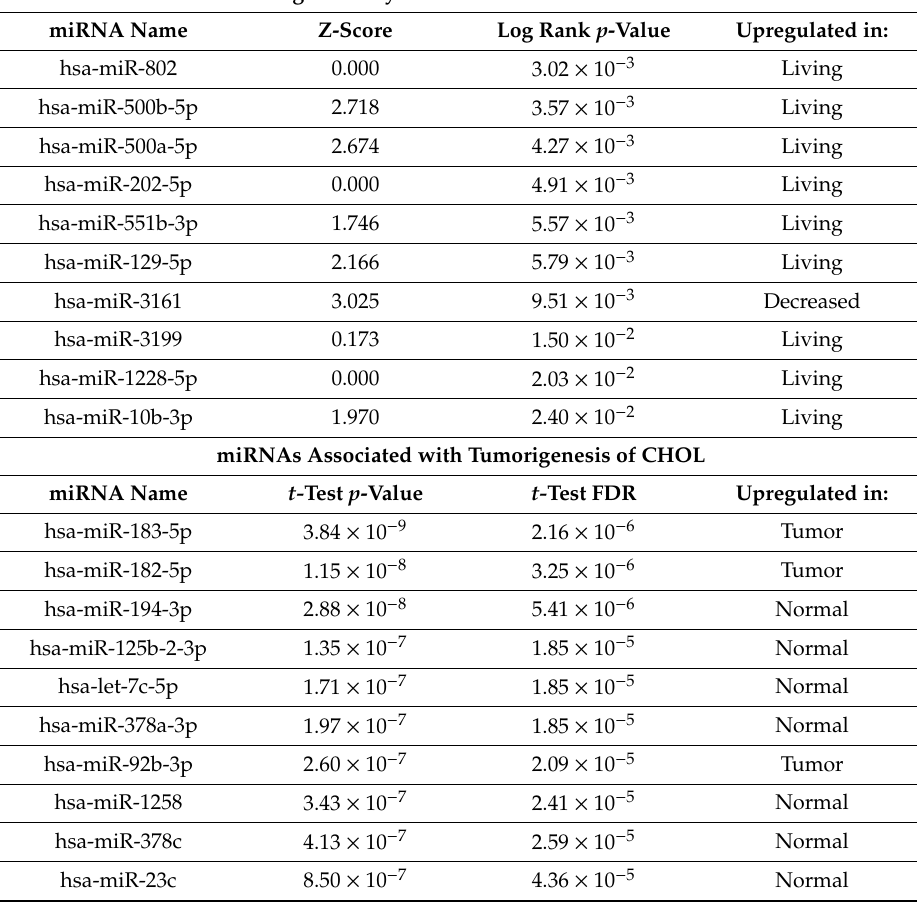
Figure 3. Most significant di ff erences of miRNAs in CCA. List selected from OncoMir Cancer Database (OMCD) website. After statistical analysis ( t -test), the top four upregulated miRNAs and the top 15 downregulated miRNAs in CCA were selected (ratio > 5 or < 0.2, p -value < 0.001). Table 2. Most significant miRNAs in CCA is related to survival rate or tumorigenesis. All candidates from WashU Pan-Cancer miRNome Atlas (OncomiR) website. Significance in tumor development was determined through paired Student’s t -test, for survival, unpaired Student’s t -test and univariate Cox proportional hazards analysis between living and decreased patients.